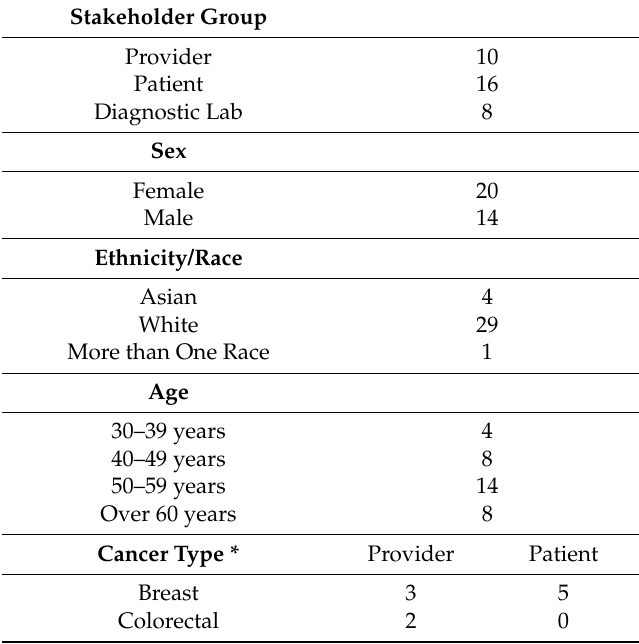
Table 1. Interview participants and demographic